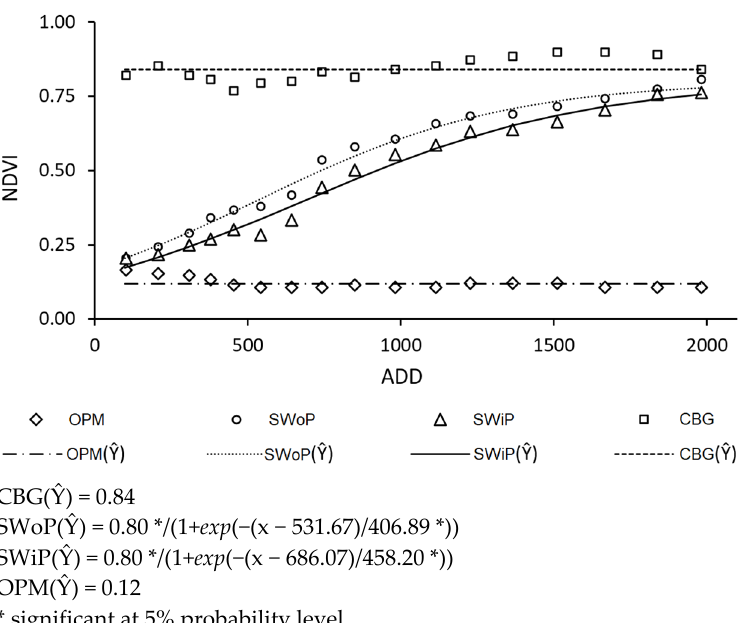
Figure 5. Normalized difference vegetation index (NDVI) in lysimeters cultivated with strawberry without recycled paper mulch (SWoP) and with recycled paper mulch (SWiP), lysimeter with only recycled paper mulch (OPM), and lysimeter with Bahiagrass (CBG) as a function of accumulated degree ‐ days (ADD).